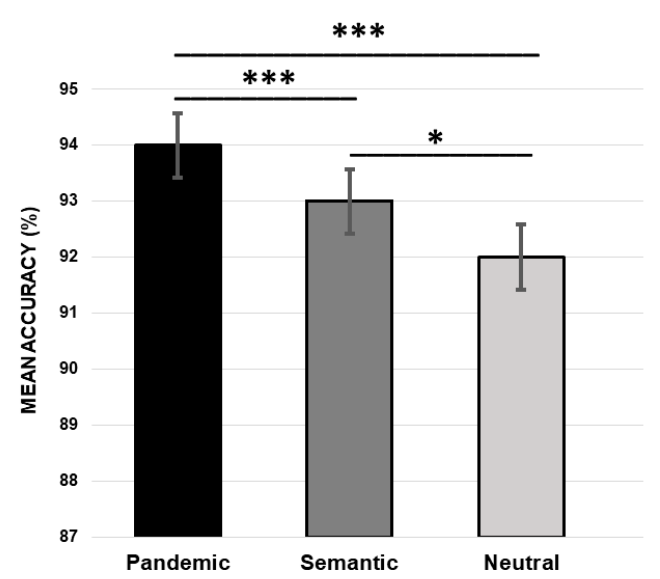
Figure 1. Mean percentage of response accuracy for pandemic, semantic, and neutral stimuli (*** p ≤ 0.001, * p ≤ 0.05).